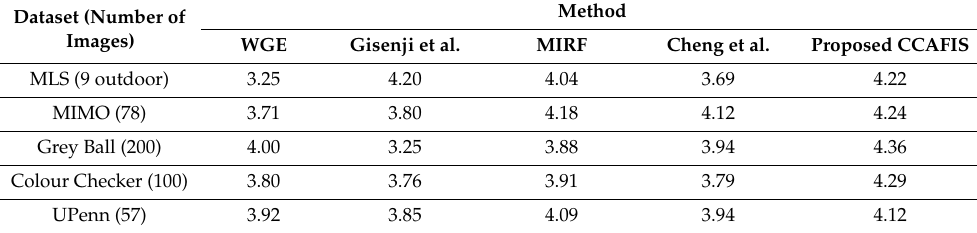
Table 2. Mean Opinion Score (MOS) of the proposed and the state-of-the-art techniques. Dataset (Number of Images)